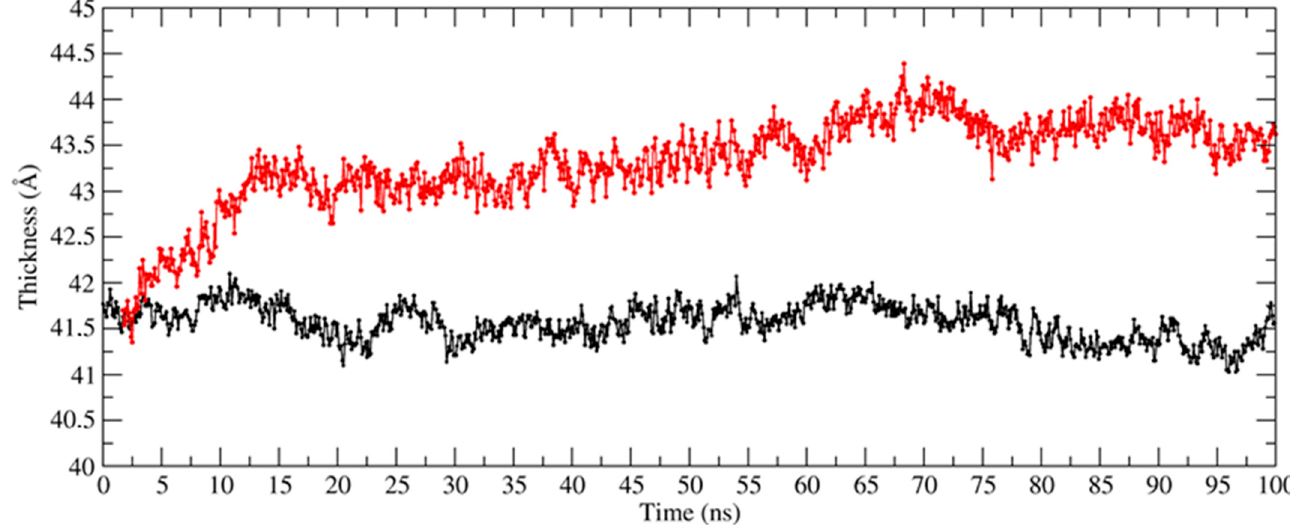
Figure 8. Membrane thickness as a function of simulation time for the system simulated in the absence (black) and presence (red) of the PEL compounds.